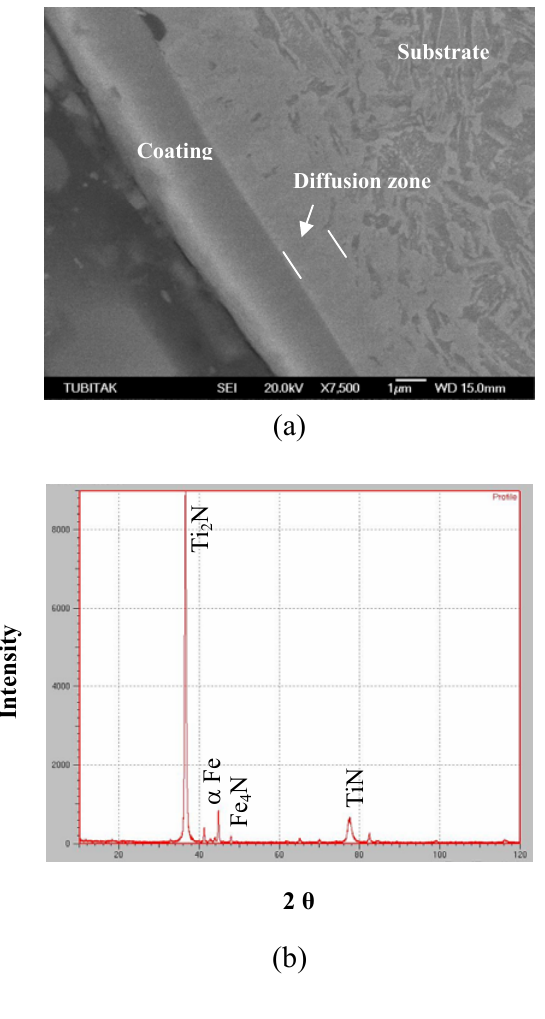
Figure 10 . TiN-coated specimen: (a) SEM micrograph showing the microstructure across the cross-section and (b) XRD